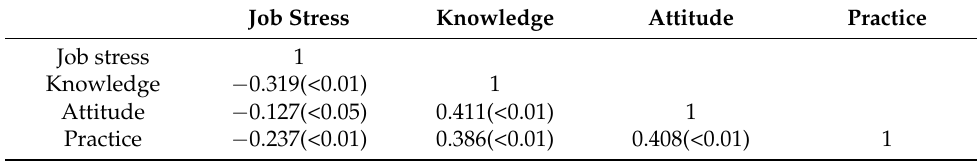
Table 3. Correlation between study variables.